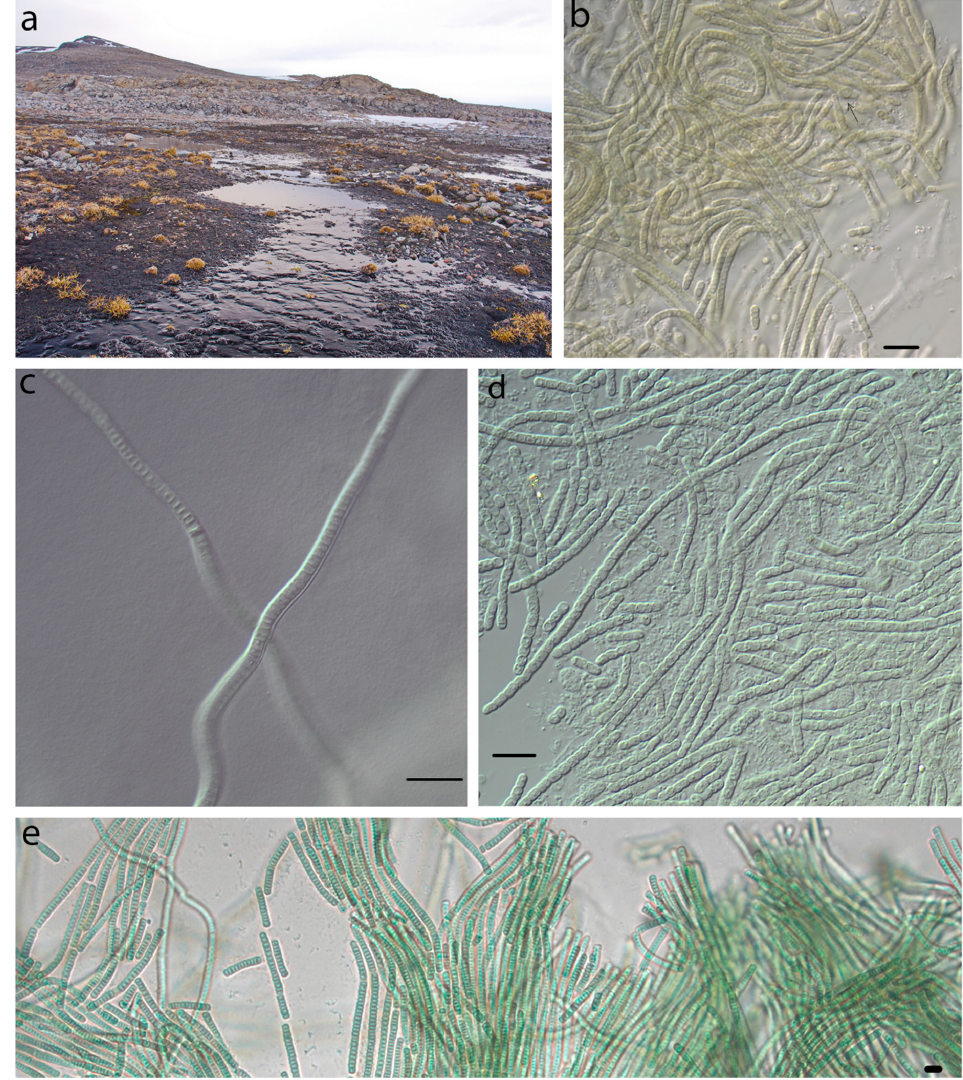
Figure 10. Morphology of cyanobacterial strains Phormidesmis communis : ( a ) habitat where strain KPABG 610024 was found; ( b – e ) DIC micro-photographs, ( b ) strain KPABG 610024, ( c ) KPABG 38552, ( d ) KPABG 132177, ( e ) KPABG 125316. Scale 10 μ m.